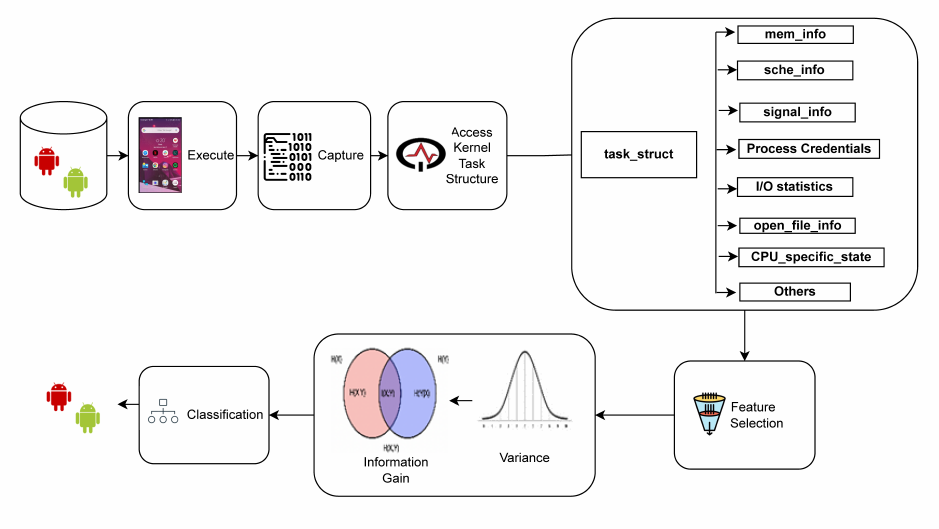
Figure 2. KTSODroid: detailed